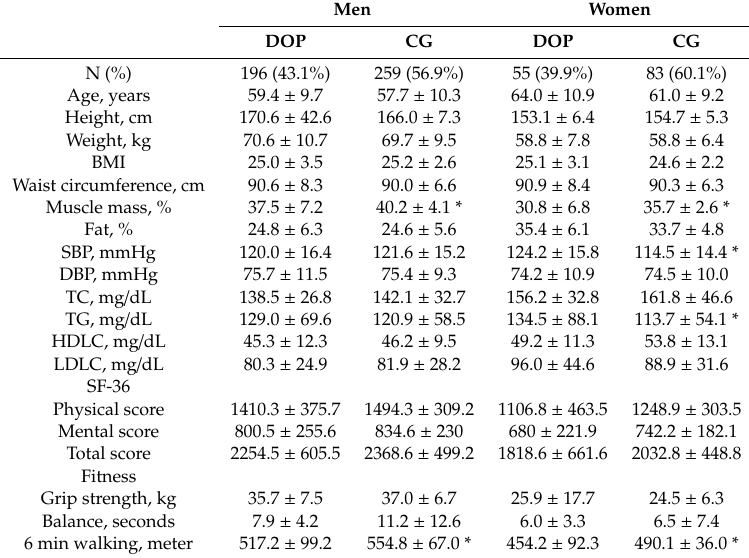
Table 2. General characteristics comparison between cardiac rehabilitation dropout patients and complete